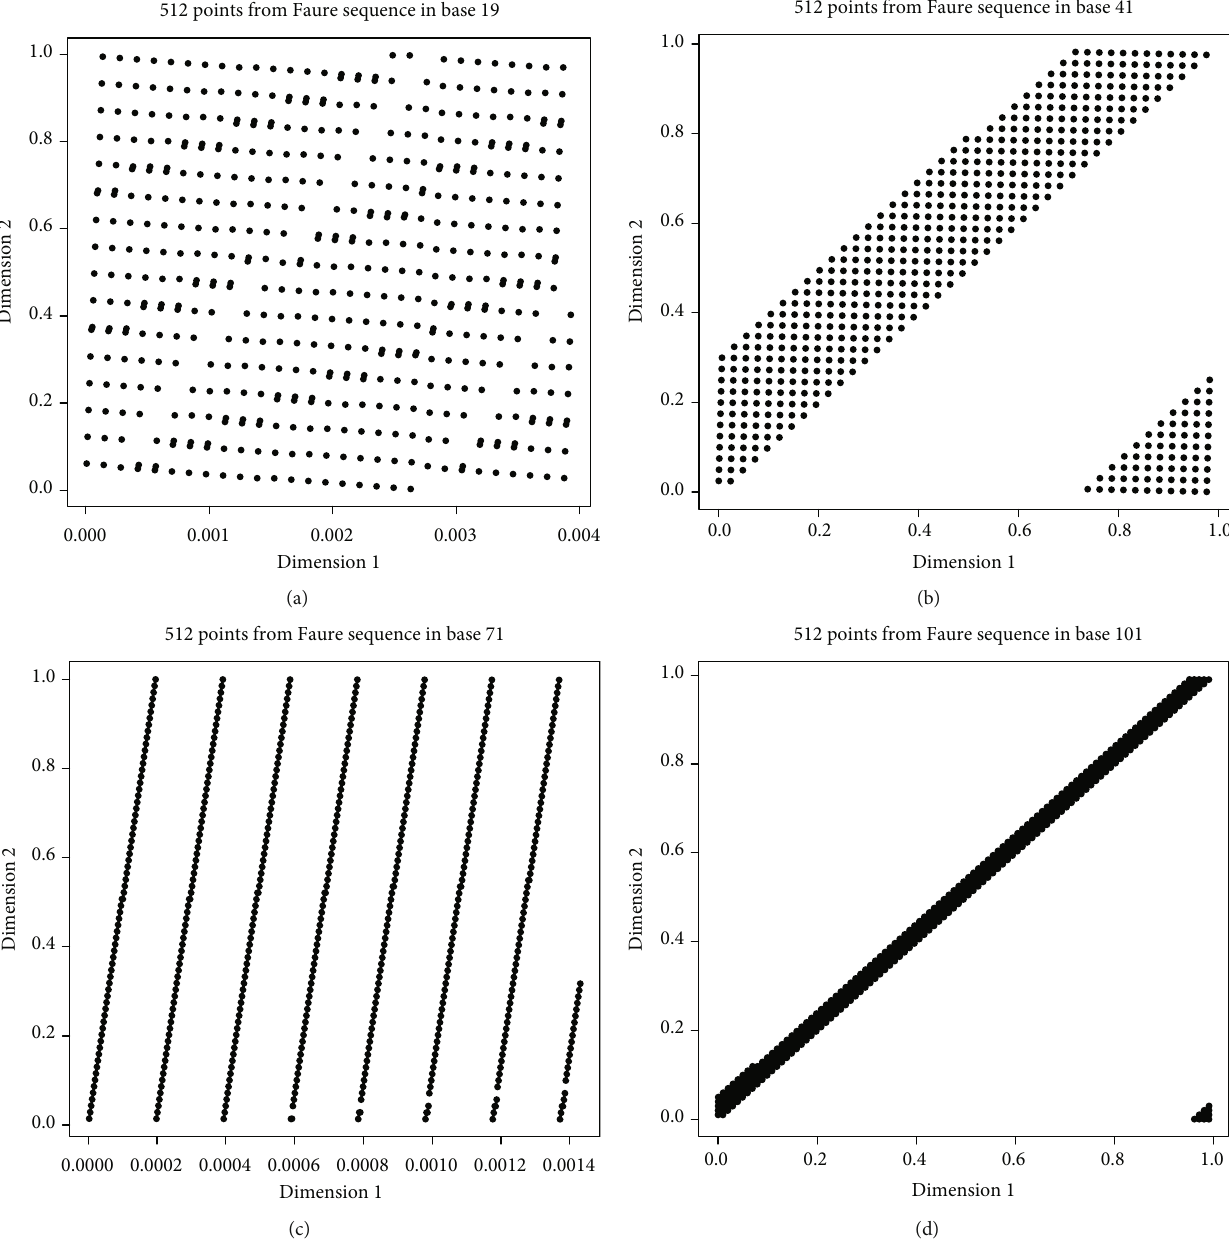
Figure 1: 512 points from the original Faure sequence in several